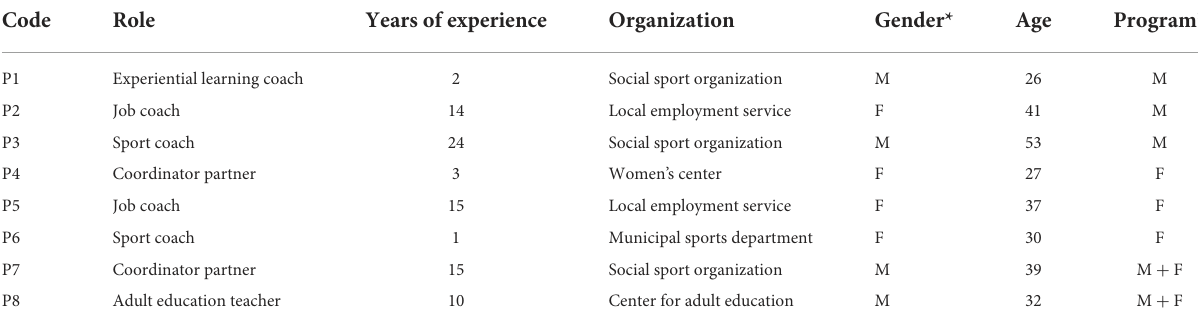
TABLE 1 Overview of the profile of